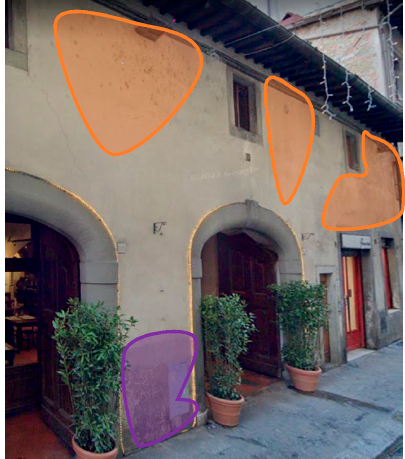
Figure 4. (From left to right)—An example of prospect and roof degradation recognition (orange area: discoloration; purple area: rising front).